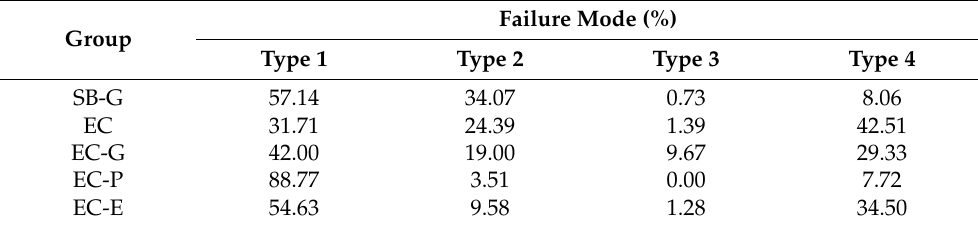
Table 3. Results of the failure mode analyses.